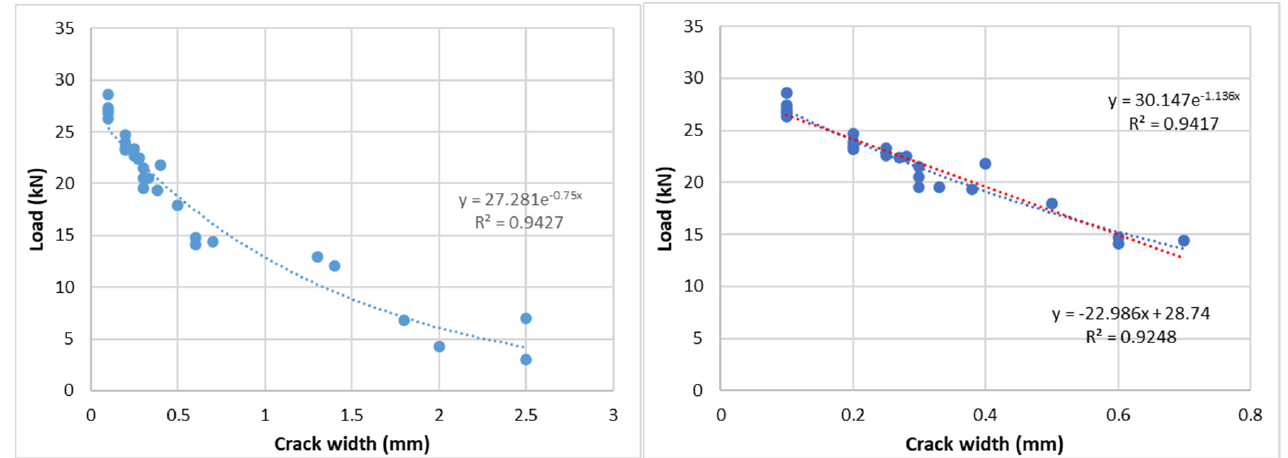
Figure 10. Load vs. crack width (all results and up to 0.7 mm).